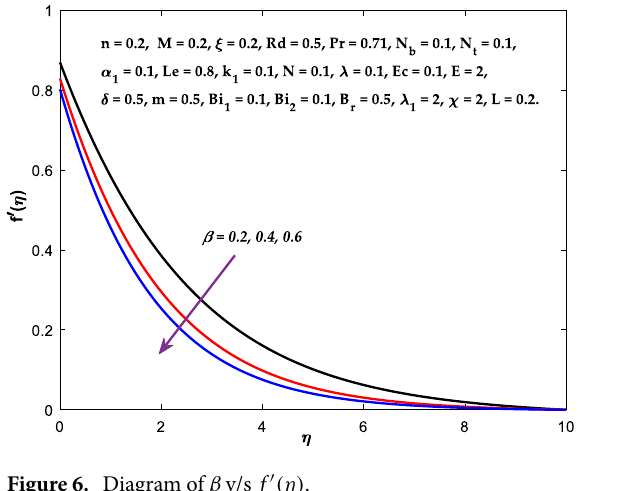
Figure 6. Diagram of β v/s f ′ (η) .